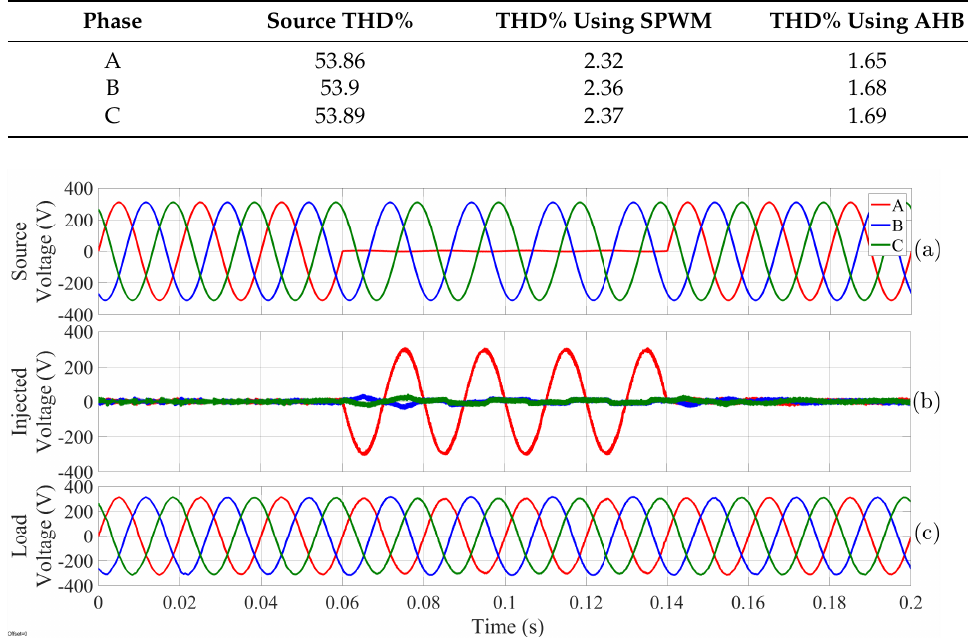
Figure 14. The simulation results of the voltage interruption ( a ) Source voltage, ( b ) injected voltage, and ( c ) load voltage. Table 9. The THD for the case of voltage interruption.